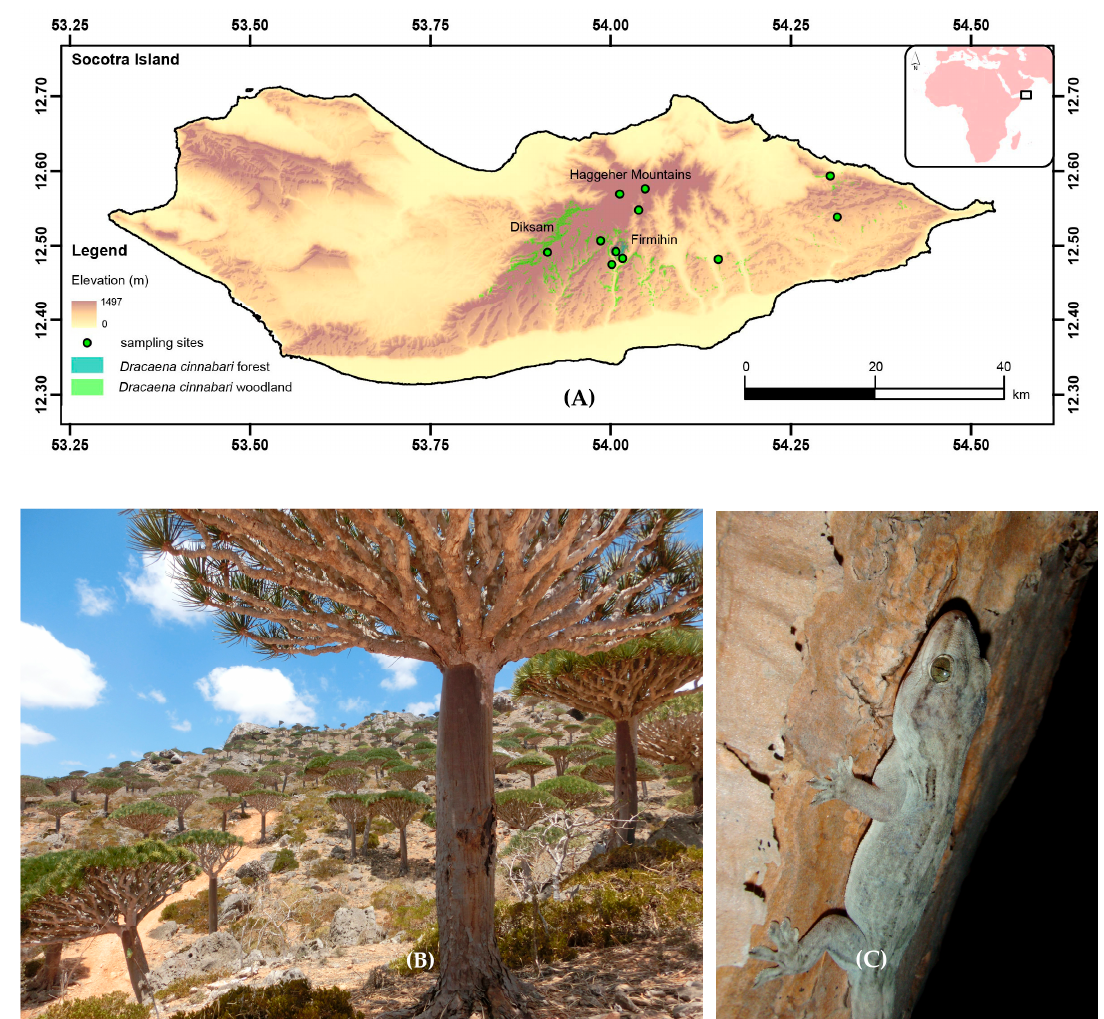
Figure 1. Map of Socotra Island ( A ) with the distribution of Dracaena cinnabari Balf.f. (green area) and the 11 study sites (green points), a general view of the D. cinnabari forest at Firmihin’s plateau, ( B )